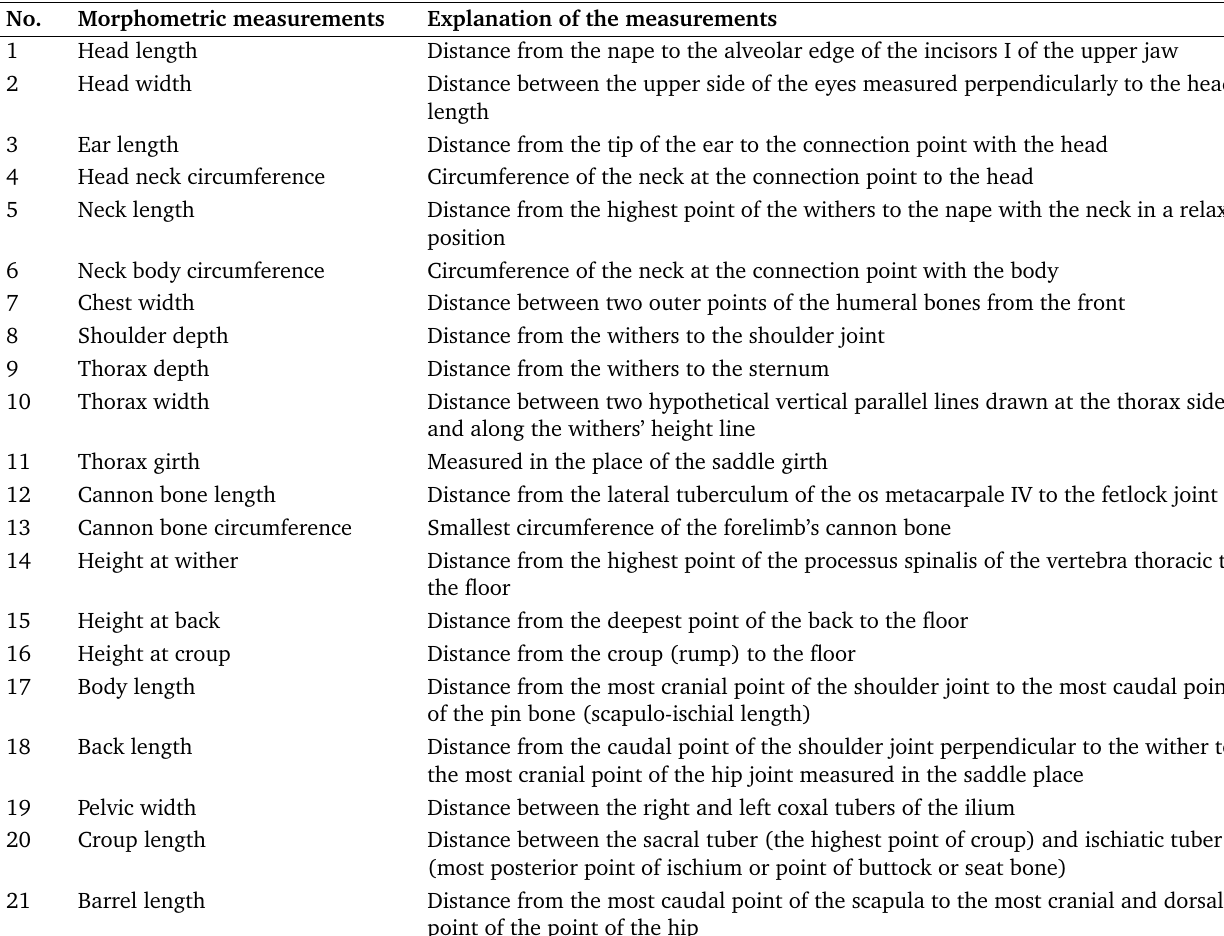
Table 2. Description of the collected quantitative measurements. Adapted from FAO (2012); Kefena et al